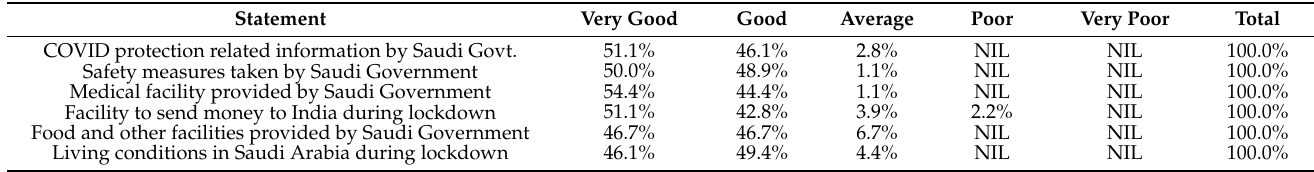
Table 5. Perceptions of the migrants towards COVID-19 management by Government of Saudi Arabia.